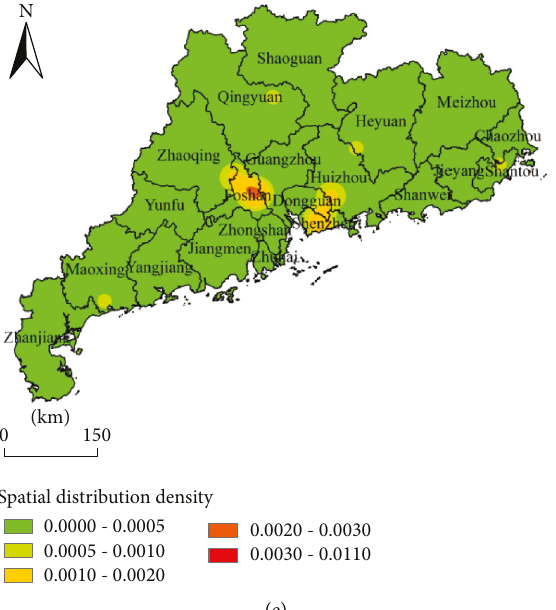
Figure 5: Estimation of nuclear density of various types of Characteristic Towns in Guangdong Province (a) Industrial development; (b) Agricultural service; (c) Commercial circulation; (d) Cultural tourism; (e) Innovative and